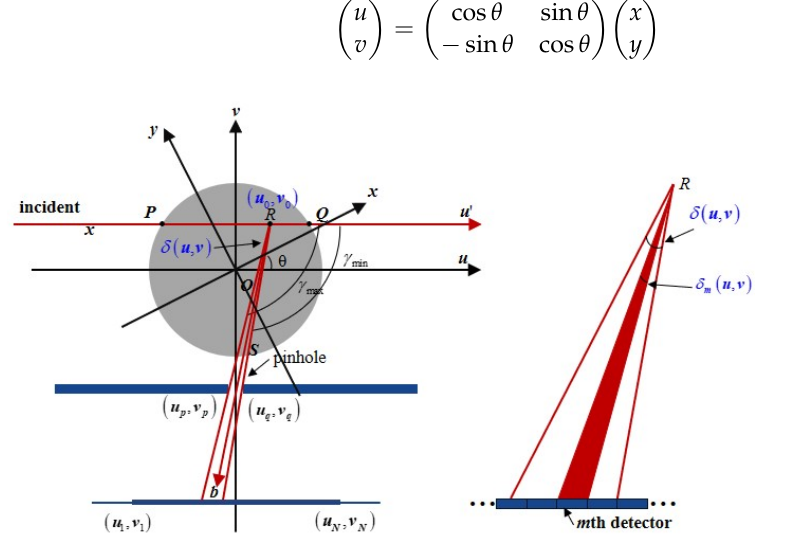
Figure 2. Imaging geometry of XFCT with pinhole collimator .